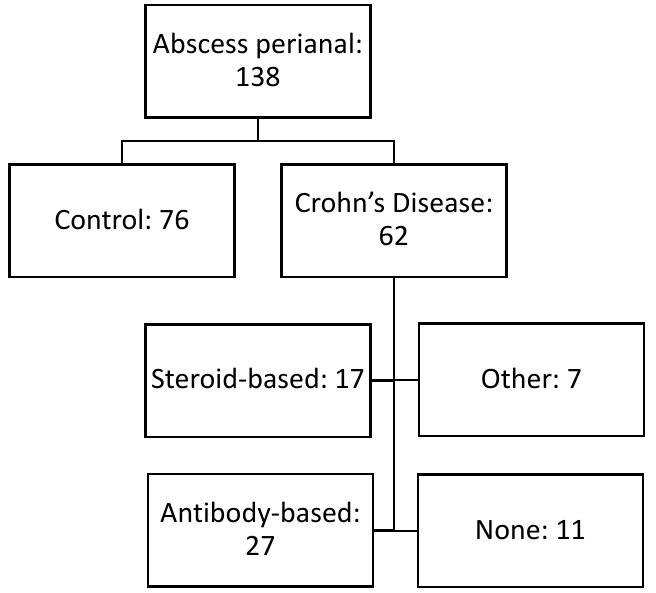
Figure 1. Study Figure 1. Study design. Table 1. Patient characteristics. BMI body mass index, CVRF cardiovascular risk factors, COPD chronic obstructive pulmonary disease, ASA American Society of Anesthesiologists, Hb hemoglo- bin, CRP C-reactive protein.